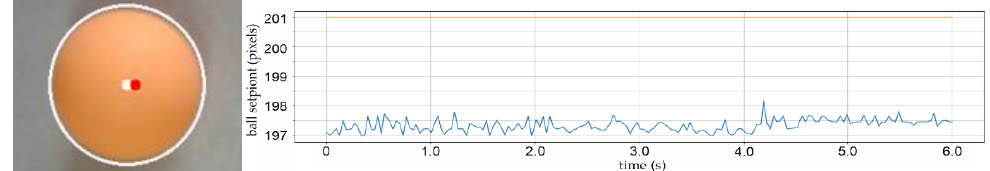
Figure 19. Specific difference between the distance of the actual (red dot) and setPoint (white dot) ball position. ball